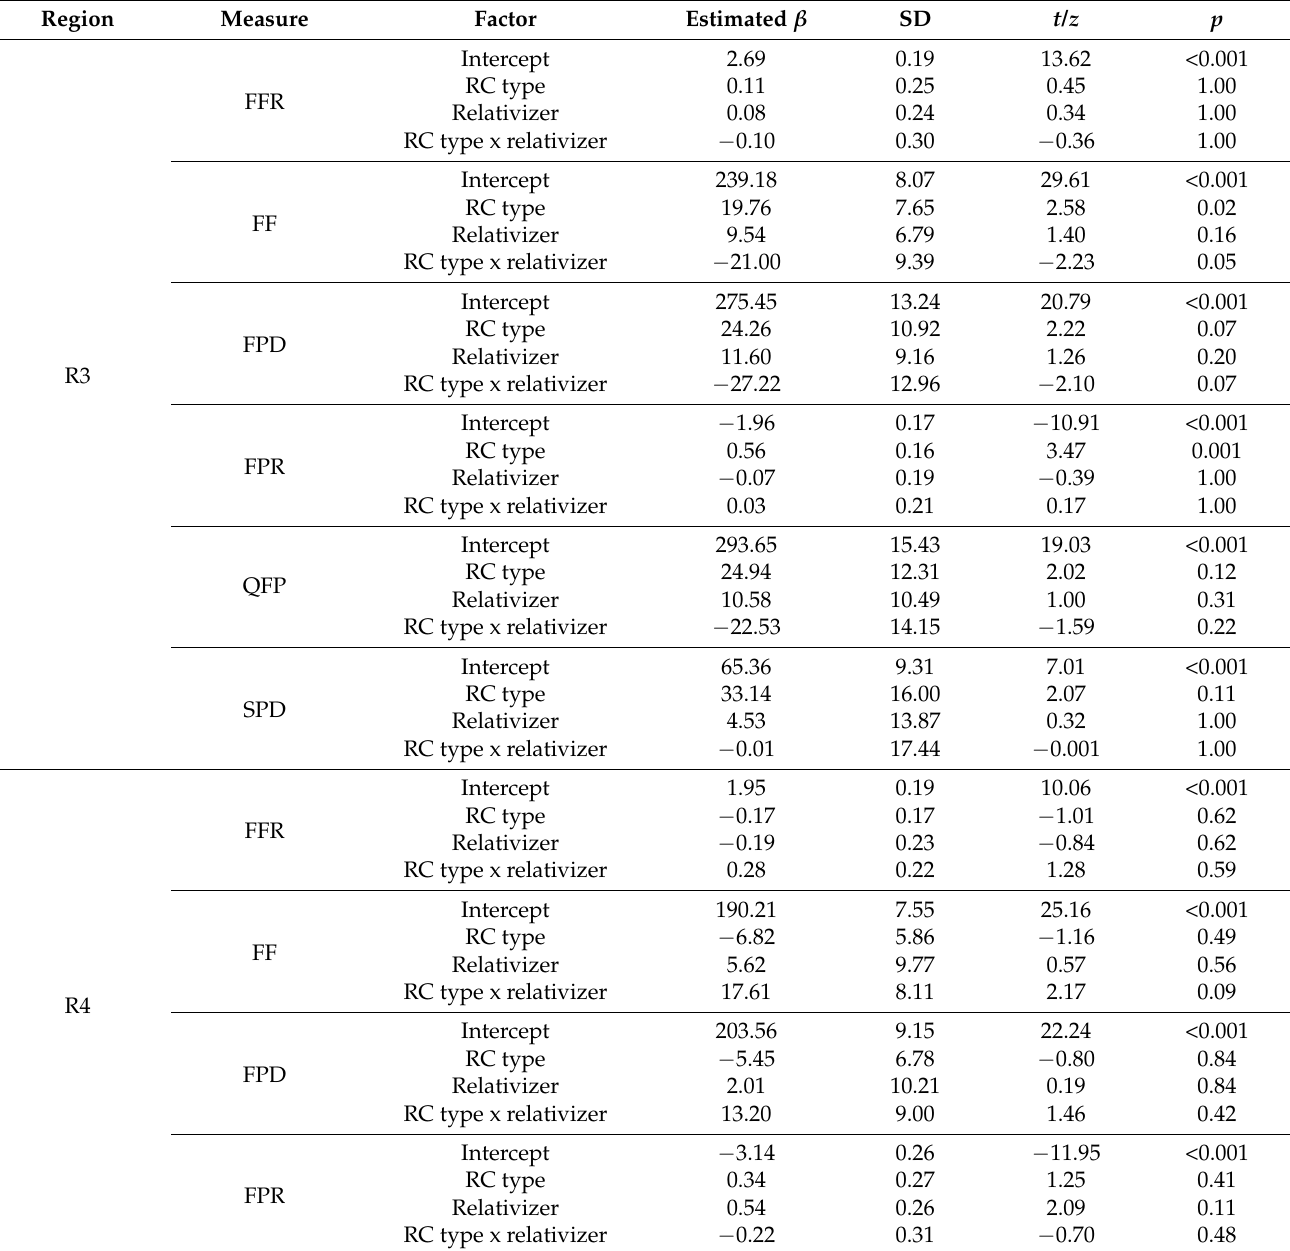
Table 8. Estimated values from the linear mixed-effect models and mixed-effect logistic regression for the contrast que versus donde at R3, R4, and R5. Eye movement measures are first-fixation rate (FFR), first fixation (FF), first-pass duration (FPD), first-pass regression (FPR), quasi-first-pass reading time (QFP), and second-pass duration (SPD). t -values refer to reading time measures and z -values refer to probability